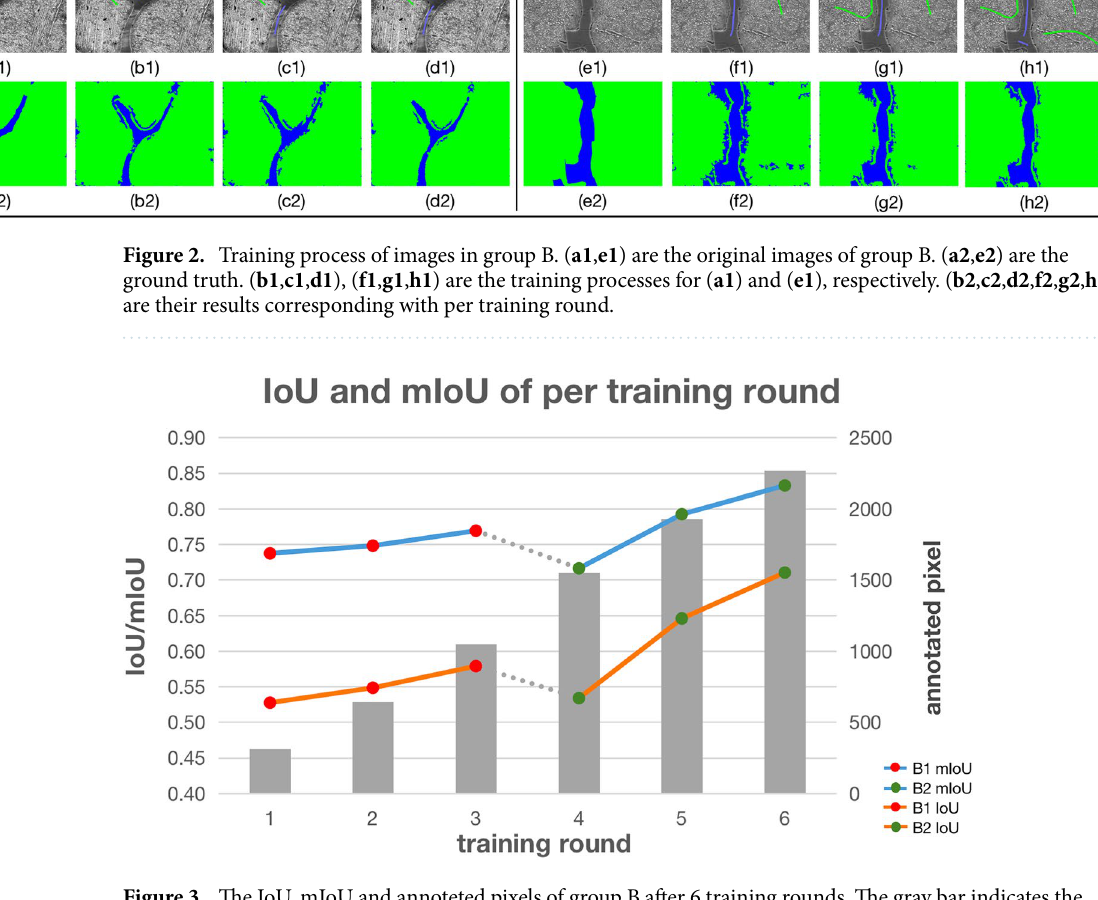
algorithm 12 , decision tree (DT) 13 , K Near Neighbor (KNN) 14 , naive bayes 15 , K-means 16 , support vector machine (SVM) 17 with different kernel functions, random forest (RF) 18 , Adaptive Boosting (AdaBoost) 19 , extreme Gradi- ent Boosting (XGBoost) 20 , Dropouts meet multiple additive regression trees (DART) 21 and Gradient Boosting